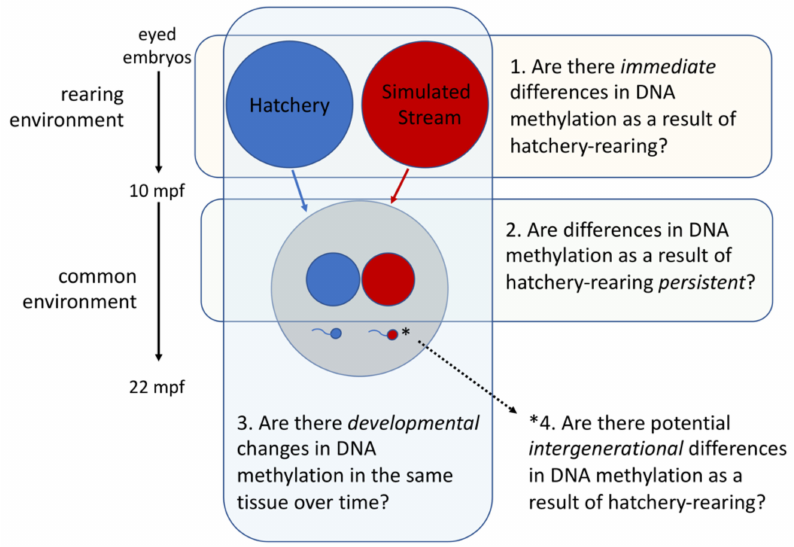
Figure 1. Schematic representation of the experimental design (mpf = months post